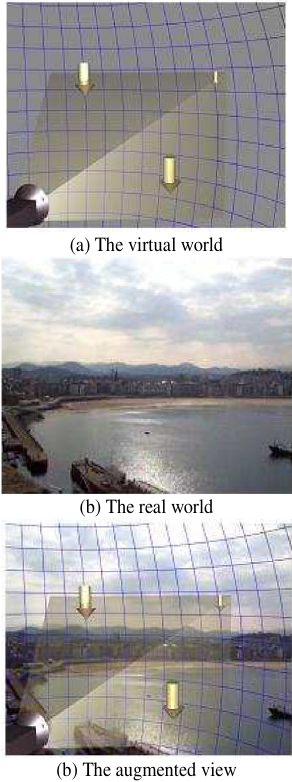
Figure 6. Building the Augmented view (Fritz et al,